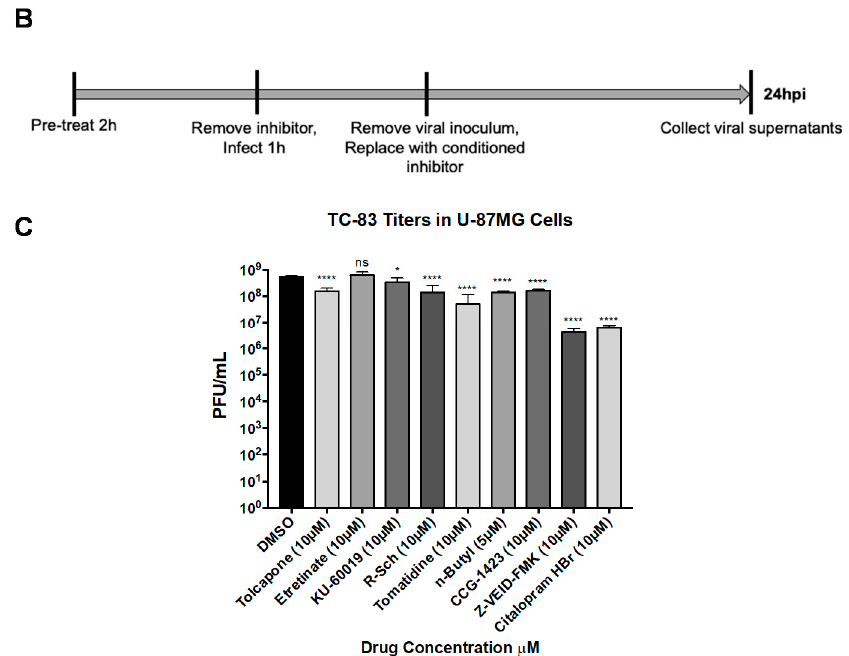
Figure 2. Efficacy of inhibitors against VEEV TC-83 in U-87MG astrocytes. ( A ) U-87MG cells were treated with small molecule inhibitors at varying concentrations ( μ M). Cell viability was measured at 24 hpt and calculated versus the DMSO vehicle control, as described in Materials and Methods. The dotted line represents the 90% cut-off point. ( B ) Schematic of experimental setup. ( C ) U-87MG cells were treated with a single, nontoxic concentration of inhibitor or 0.1% DMSO for 2 h. Cells were infected with TC-83 at MOI of 0.1 in triplicate for 1 h. Conditioned media containing inhibitor was replaced after removal of the virus. At 24 hpi, viral supernatants were collected and evaluated by plaque assay, as described in Materials and Methods. Graph represents data from two independent experiments performed in triplicate ( n = 6). * p < 0.0332, **** p < 0.0001, ns, not significant.